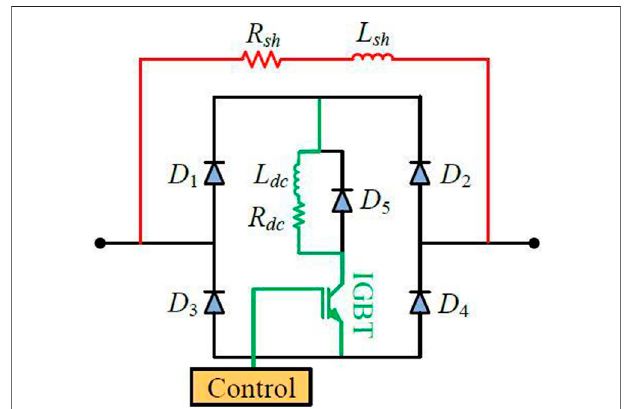
FIGURE 4 | Control structure of the BFCL in the PMSG wind turbine.